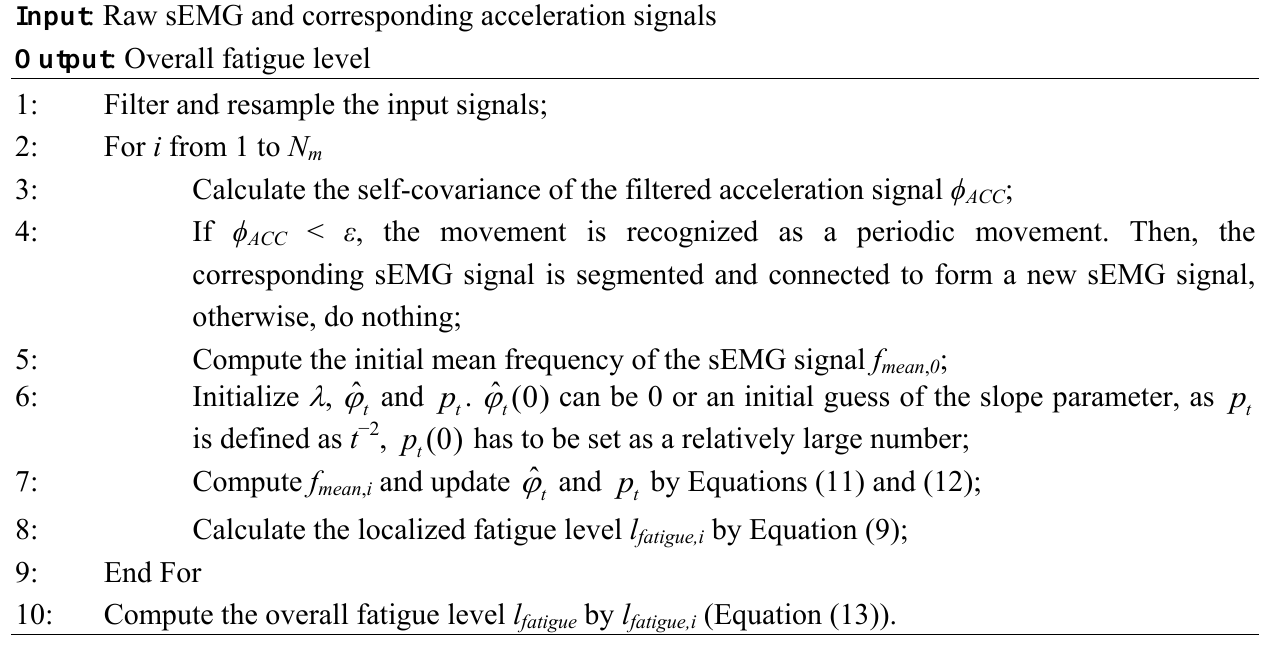
Algorithm 1 : Overall fatigue level